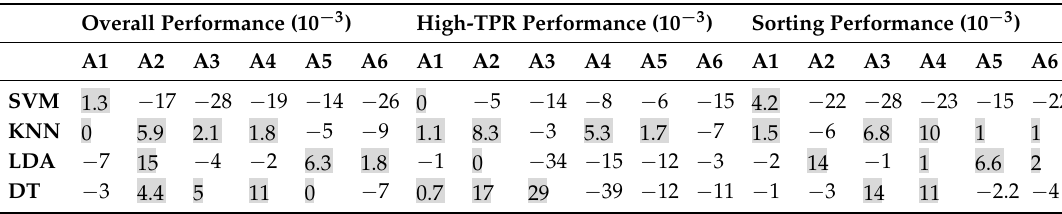
Table 6. The difference of mean performance numbers between using and not using RRAS. The positive differences are marked with gray. A1 to A6 stand for ACS-1 to ACS-6. Overall Performance (10 − 3 )